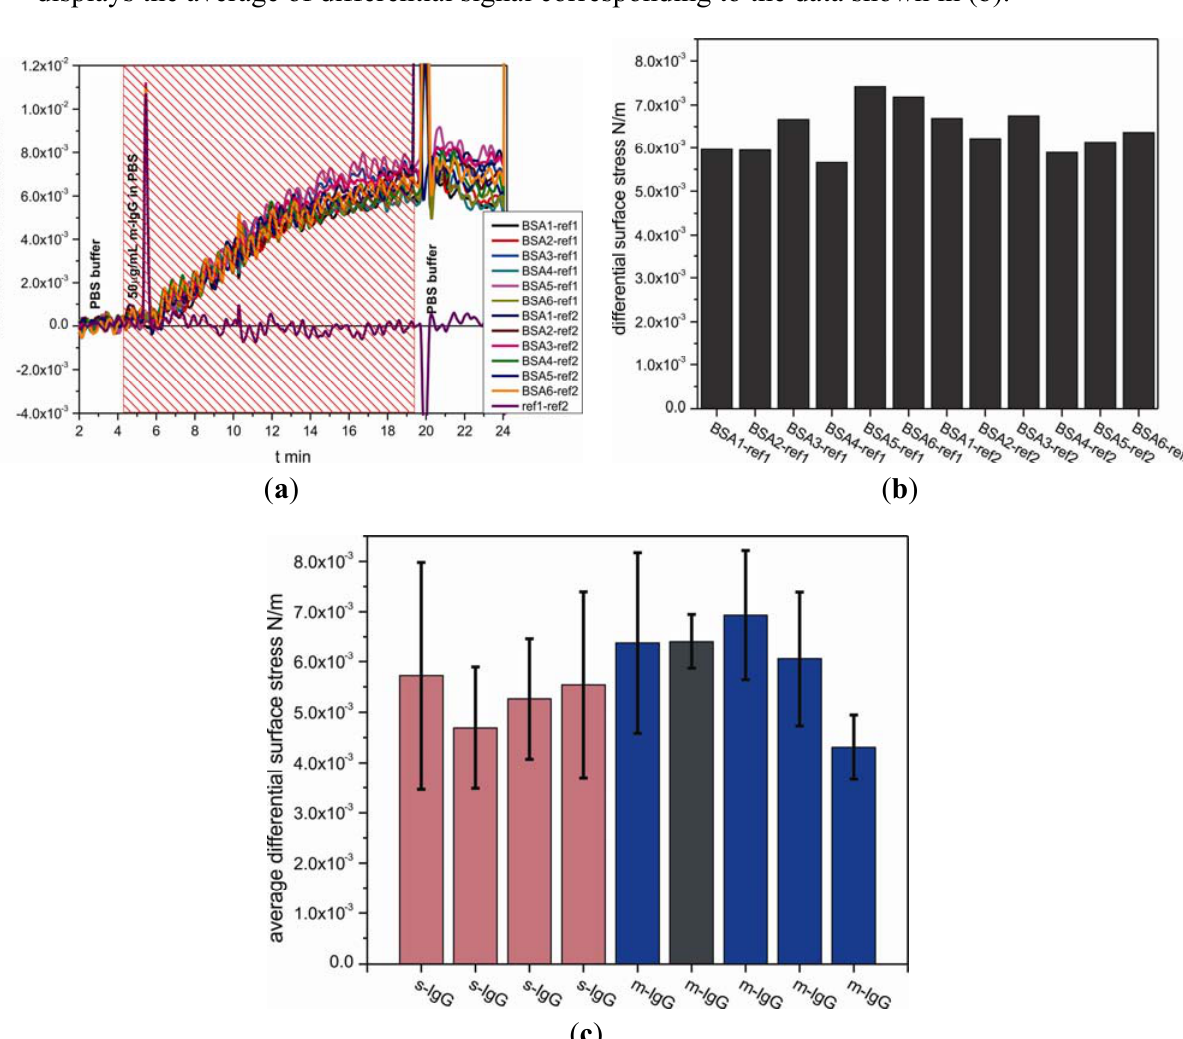
Figure 6. ( a ) shows individual measurement curves analyzed for one out of nine cantilever arrays. In this experiment, the sensor cantilevers were immobilized with bBSA as the sensing layer, only two cantilevers served as reference cantilevers. The difference in responses between a sensor and a reference cantilever shows that the sensor cantilevers bent upward (producing a positive signal), corresponding to tensile surface stress. ( b ) Bar graph showing the individual differential bending signal values for each curve. ( c ) Each bar represents the average independent measurements of the difference in responses of a sensor and a reference cantilever. Measurements were carried out on nine different arrays (displayed by nine bars). Recognition between bBSA and antibody (either s-IgG (pink bars) or m-IgG (blue including dark grey bars)) produced mean deflections that do not differ significantly for both the 4 s-IgG arrays and the 5 m-IgG arrays. The dark grey bar displays the average of differential signal corresponding to the data shown in (b).